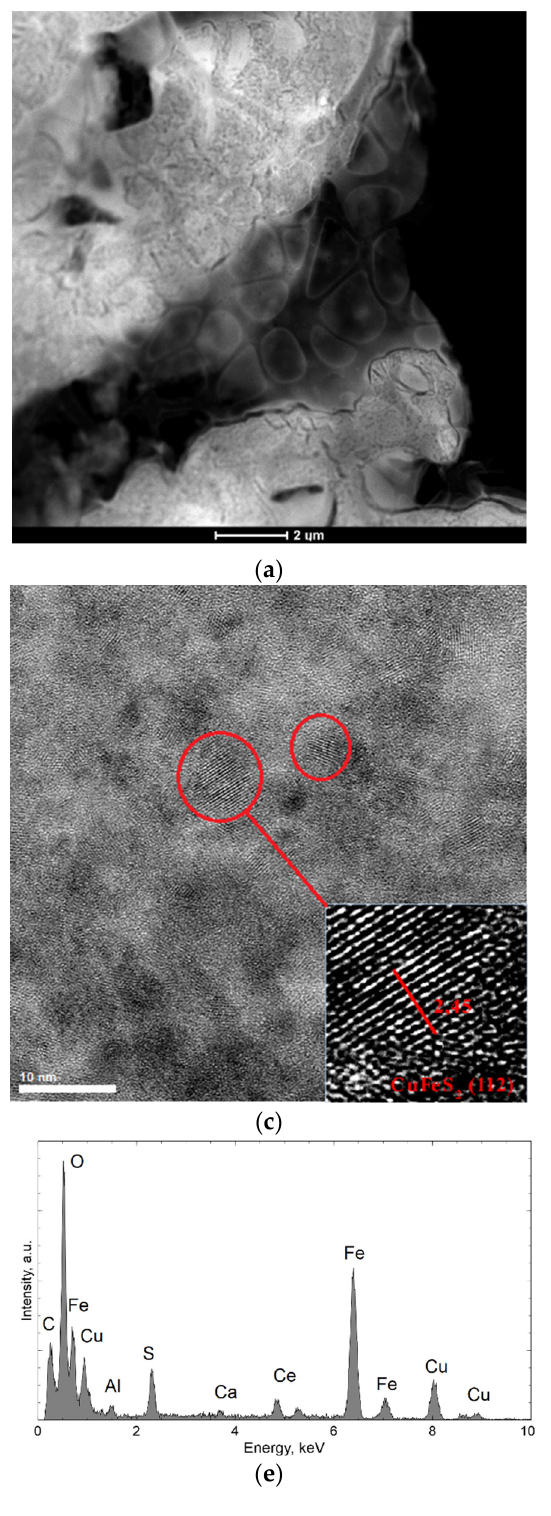
Figure 7. Microscope images of the dried residues precipitated from control solution; ( a ) undiluted (STEM HAADF), ( b ) diluted (STEM B), ( c ) TEM image of the outer part of bigger spherical particle from ( b ), ( d ) STEM-HAADF image consist of spherical and unregular fragments, where EDS analysis were performed, ( e ) EDS result obtained in area indicated by A in ( d ); ( f ) EDS result obtained in area indicated by B in ( d ).